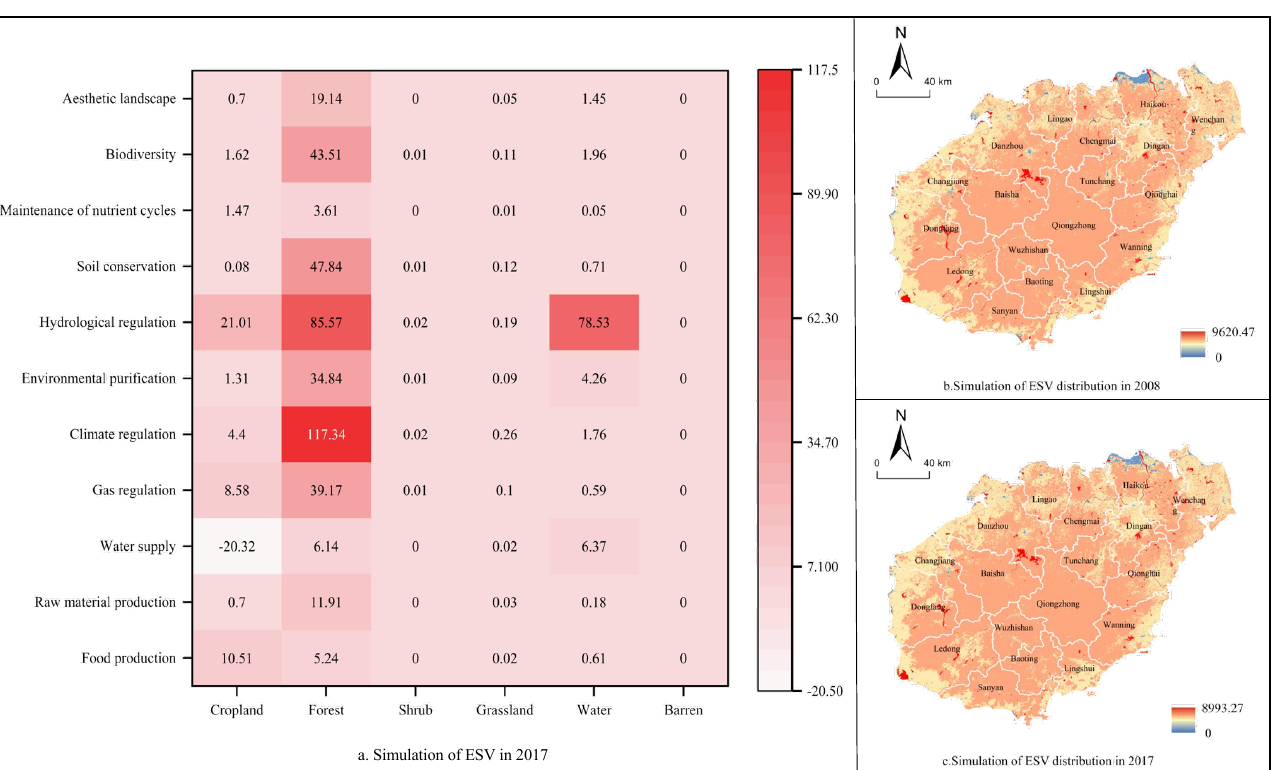
Figure 5. ESV model simulation results, 2017.